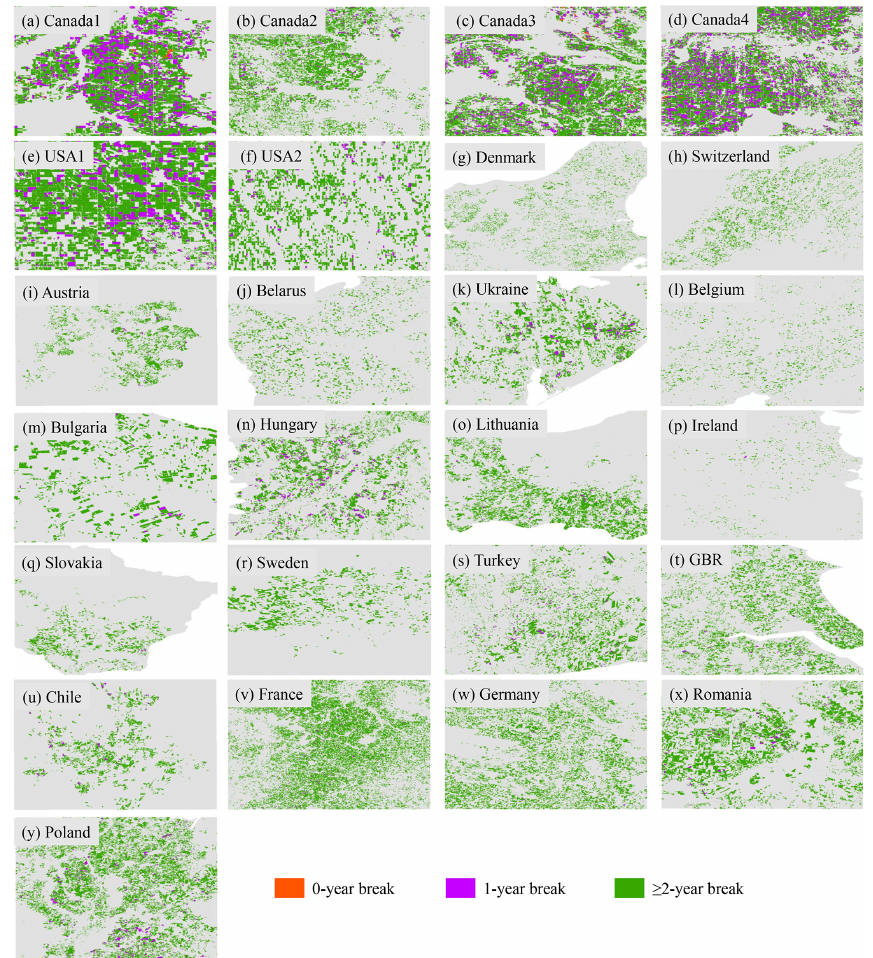
Figure 11. Spatial distribution of three rotation schedules in different areas from